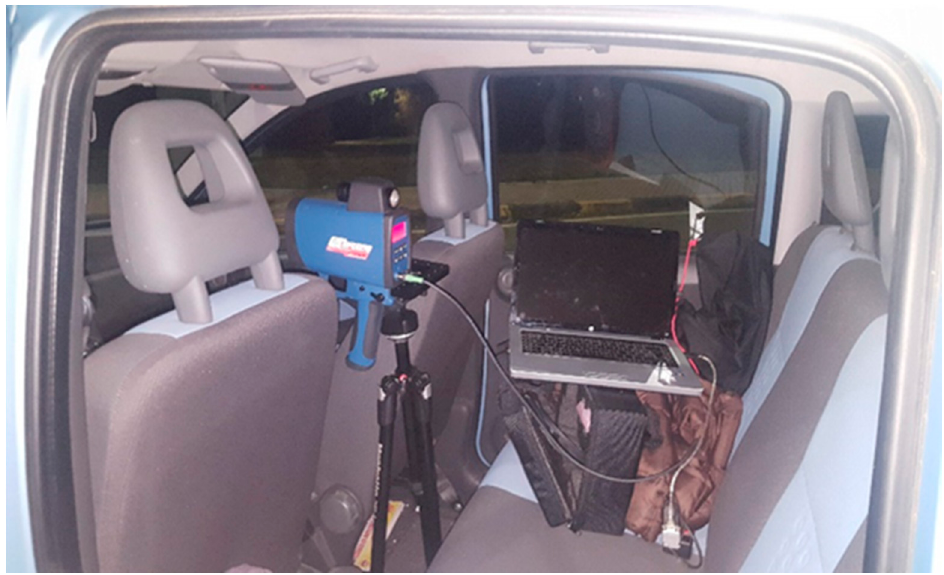
Figure 2. Speed data collection with the telelaser hidden in the car.